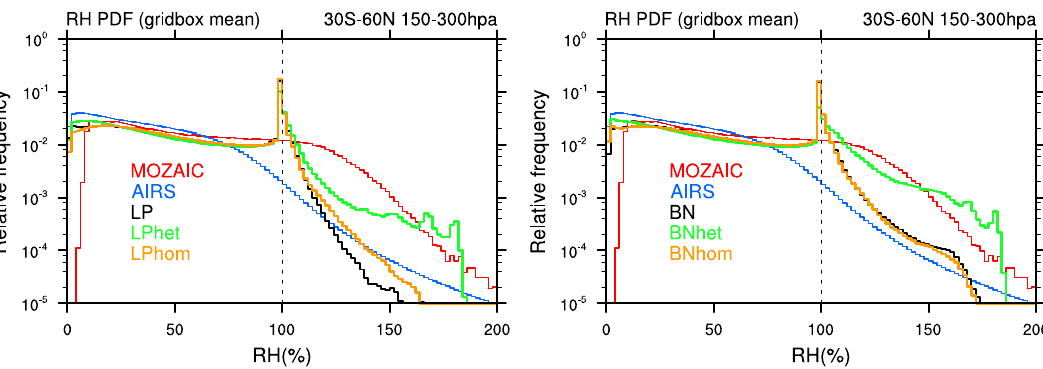
Fig. 6. Probability distribution frequency (PDF) of relative humidity in 150–300hPa from 30 ◦ S to 60 ◦ N from pure homogeneous, pure heterogeneous and combined nucleation simulations for LP05 (left) and BN09 (right) parameterizations, in comparison with humidity ob- servations in the upper troposphere from the Measurements of Ozone, Water Vapor, Carbon Monoxide and Nitrogen Oxides by Airbus In-Service Aircraft (MOZAIC) and from the Atmospheric Infra-Red Sounder (AIRS)